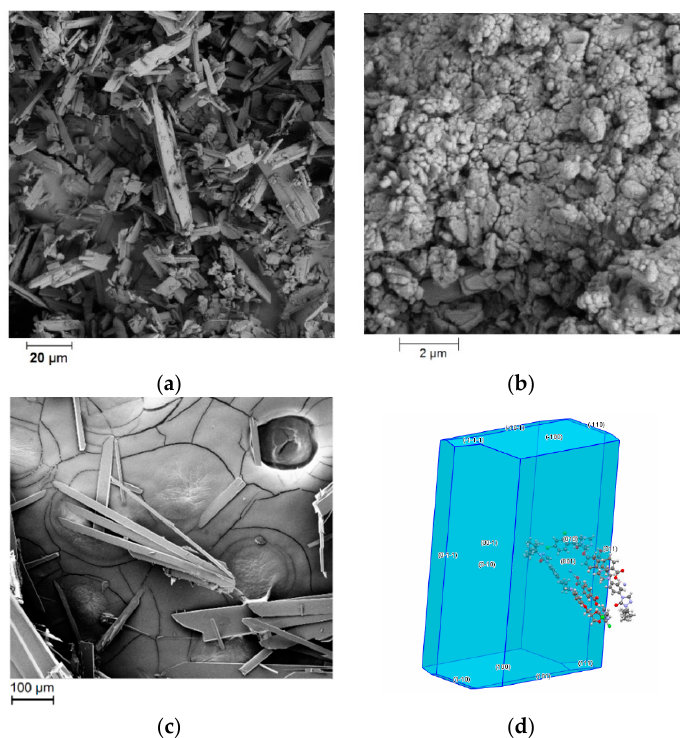
Figure 9. Scanning electron micrographs of: ( a ) crystalline ITR and the ITR–TER cocrystal produced by ( b ) ball milling, ( c ) slow solvent evaporation from methanol, as well as the ( d ) Bravais, Friedel, Donnay and Harker (BFDH) predicted morphology based on the single crystal structure of the ITR–TER cocrystal.